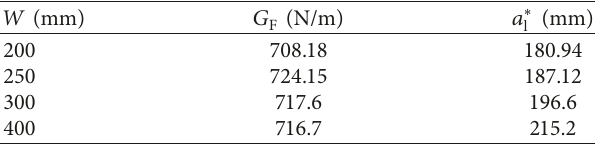
and the influence length a ∗ F